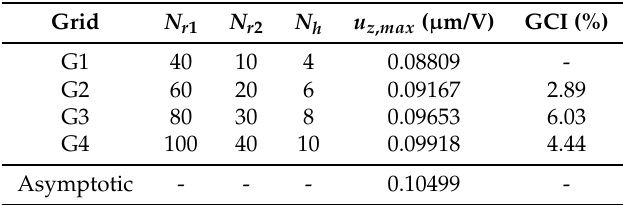
Figure 9. Mesh convergence of FEM analysis for a unimorph piezoelectric actuator in comparison with the experiment and analytical results [18]. The plots show the deflection profile with normalized radius along the bottom shim plate. Table 6. Mesh sensitivity study and convergence index for the unimorph actuator. GCI, Grid Convergence